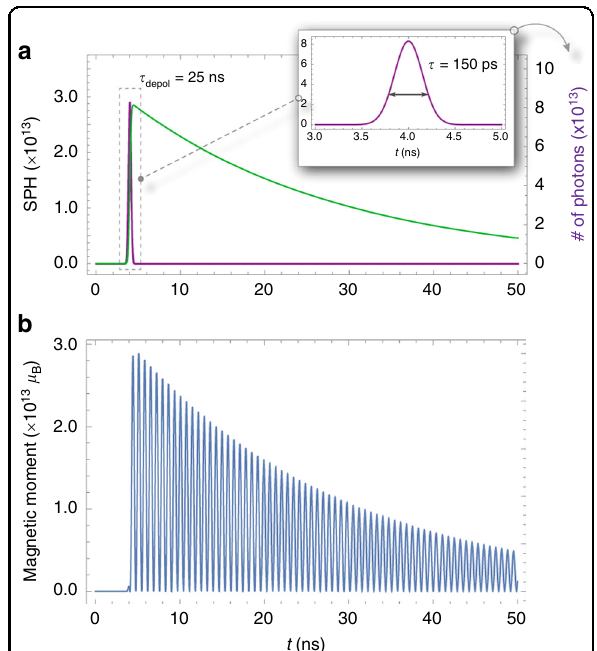
Fig. 3 Time dependence of the electron-spin polarization. a The number of SPH (green curve — left axis) as a function of time after the arrival of the dissociation pulse (shown in the inset — representing the number of photons on the right axis). After the end of the pulse, the number of SPH are decaying exponentially due to depolarization mechanisms (here the depolarization time is 25ns). b The time- dependent electron magnetization, M ( t ), calculated using Eq. (5)